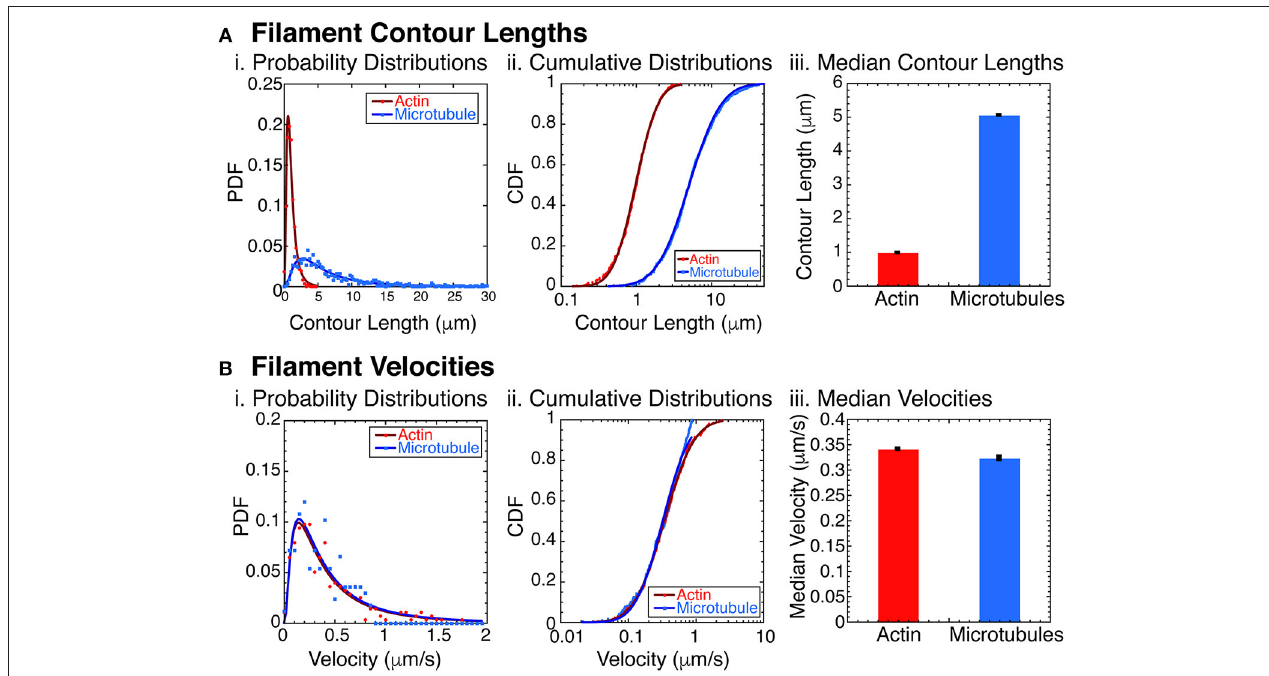
FIGURE 2 | Filament characterization. (A) Filament contour lengths were measured for actin filaments and microtubule filaments. (i) Probability distribution functions (PDFs) of actin filaments (red circles, N = 1070) and microtubules (blue squares, N = 865) were binned with 0.25 µ m sized bins and normalized. Data was fit to a lognormal function for actin (dark red line) and microtubules (dark blue line). See Supplemental Information for fit equation and Supplemental Table 1 for all fit parameters with uncertainty and goodness of fits. (ii) Cumulative distribution functions (CDFs) of the same data for actin filaments (red circles, N = 1070), and microtubules (blue squares, N = 865). CDFs were normalized and fit with the error function appropriate for lognormally distributed data for actin filaments (dark red line) and microtubules (dark blue line). See Supplemental Information for fit equation and Supplemental Table 2 for all fit parameters with uncertainty and goodness of fits. (iii) Using the fit parameters from the CDF data, we found the median contour lengths for both actin filaments (red bars) and microtubules (blue bars). Error bars represent the uncertainty of the fits parameter for the median. (B) Filament velocities were measured for actin and microtubule filaments separately. (i) PDFs of actin filament velocities (red circles, N = 276) and microtubules (blue squares, N = 167) were binned with 0.05 µ m/s sized bins and normalized. Data was fit to a lognormal function for actin (dark red line) and microtubules (dark blue line). See Supplemental Information for fit equation and Supplemental Table 3 for all fit parameters with uncertainty and goodness of fits. (ii) Cumulative distribution functions (CDFs) of the same data for actin filaments (red circles, N = 276), and microtubules (blue squares, N = 167). CDFs were normalized and fit with the error function appropriate for lognormally distributed data for actin filaments (dark red line) and microtubules (dark blue line). See Supplemental Information for fit equation and Supplemental Table 4 for all fit parameters with uncertainty and goodness of fits. (iii) Using the fit parameters from the CDF data, we found the median filament velocities for both actin filaments (red bars) and microtubules (blue bars). Error bars represent the uncertainty of the fits parameter for the